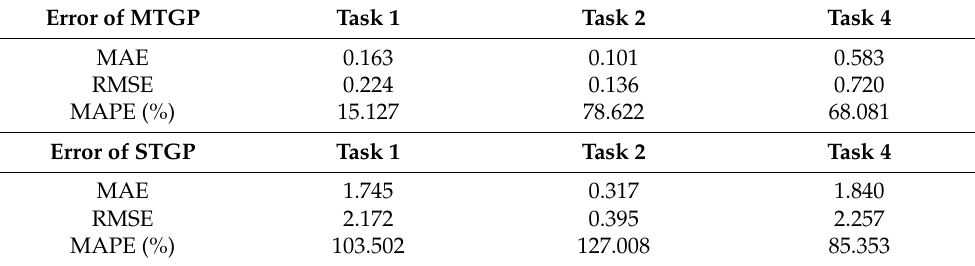
Figure 5. Imputation results of MTGP and STGP for S1. (2) S2—Different Sampling Frequencies Table 2. Error results of MTGP and STGP for